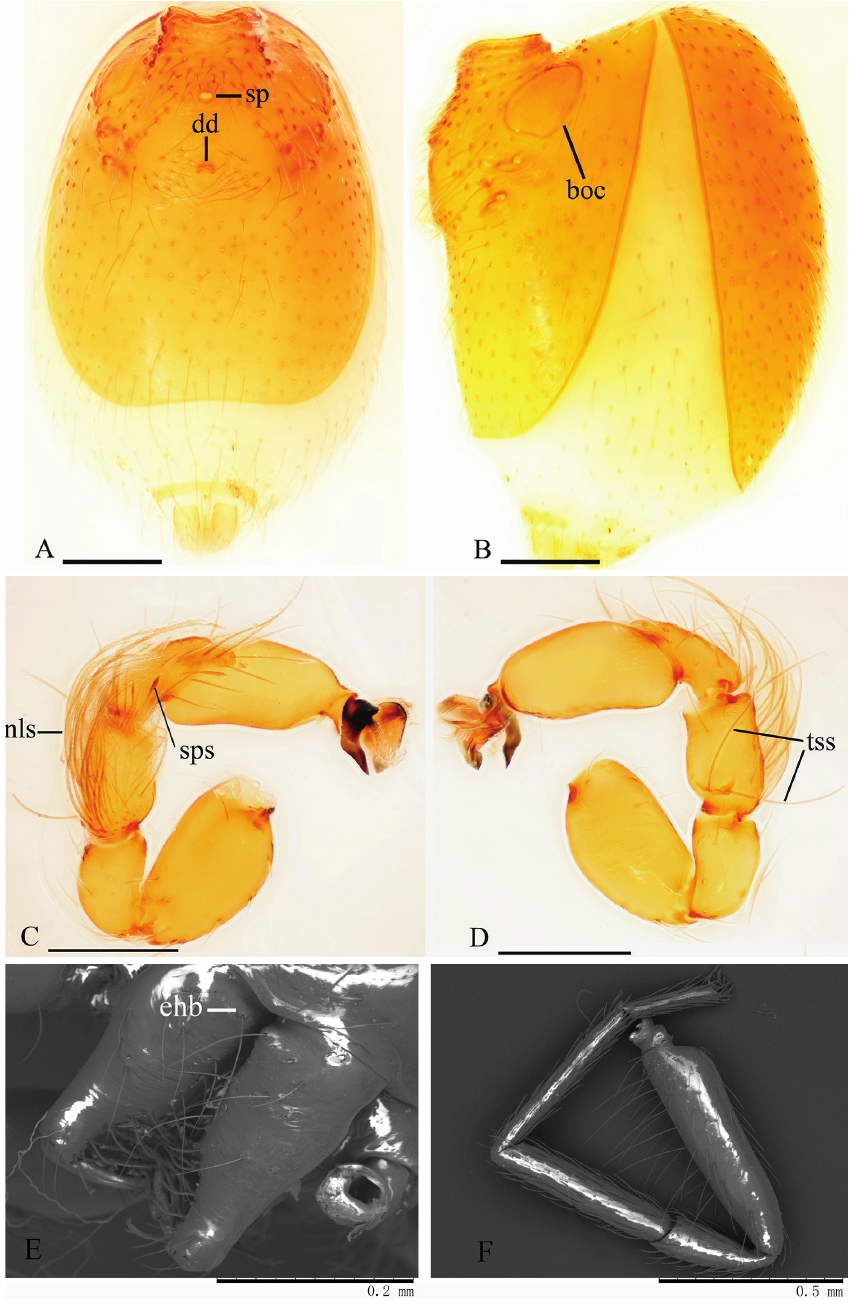
Figure 7. Trilacuna songyuae sp. n., male. A abdomen, ventral view B abdomen, lateral view C left palp, prolateral view D left palp, retrolateral view E chelicerae, oblique, anterior view F left leg IV, prolateral view. Abbreviations: boc = booklung covers; dd = dark dot; ehb = elevated hair base; nls = numerous, long setae; sp = sperm pore; sps = spear-like setae; tss = two long, strong setae. Scale bars: 0.1 mm ( A–D